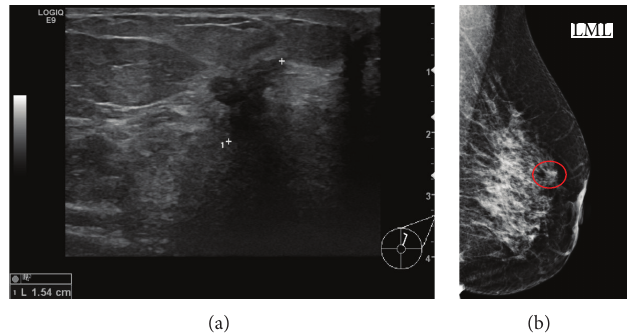
Figure 2: (a) Ultrasound of the left breast showing a 15mm ill-defined hypoechoic mass. (b) Mammogram of left breast (mediolateral view) demonstrates a spiculate mass (red circle).